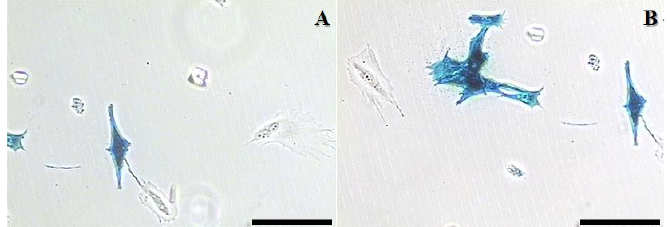
FIGURE 3 - Representative figures of expression of ß-Gal (blue) by LacZ gene reporter observed in the bone-marrow stem cells of ovines (A,B). Scale bar: A, B =